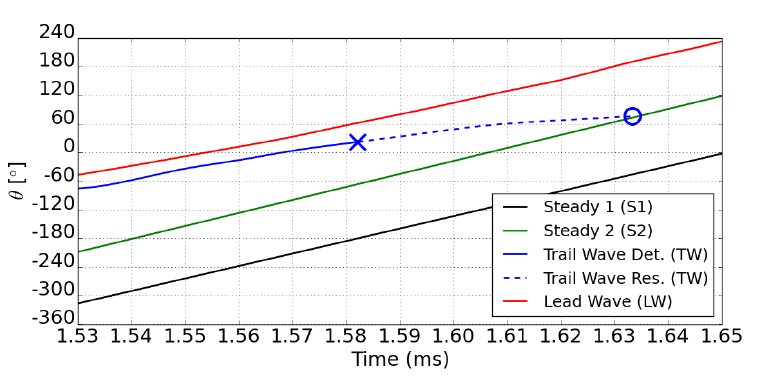
Figure 12. Relative wave positions within ± 1.3 ◦ to 2.3 ◦ during DMT, ‘x’ denotes trailing detonation wave failure, circle denotes merger of the residual trailing wave pressure component with steady